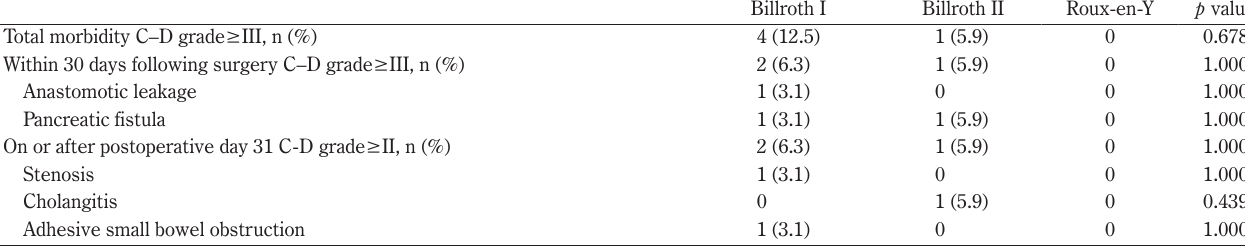
Table 4 Postoperative complications of distal